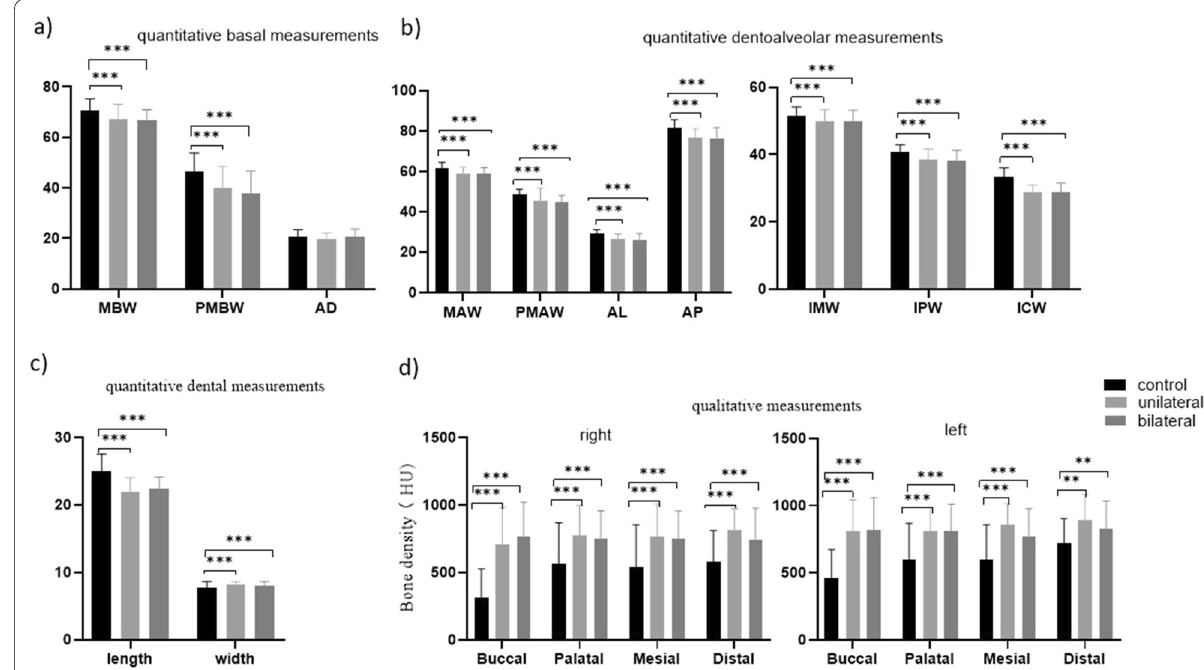
Fig. 5 Comparison of the qualitative and quantitative measurements between impacted and control groups